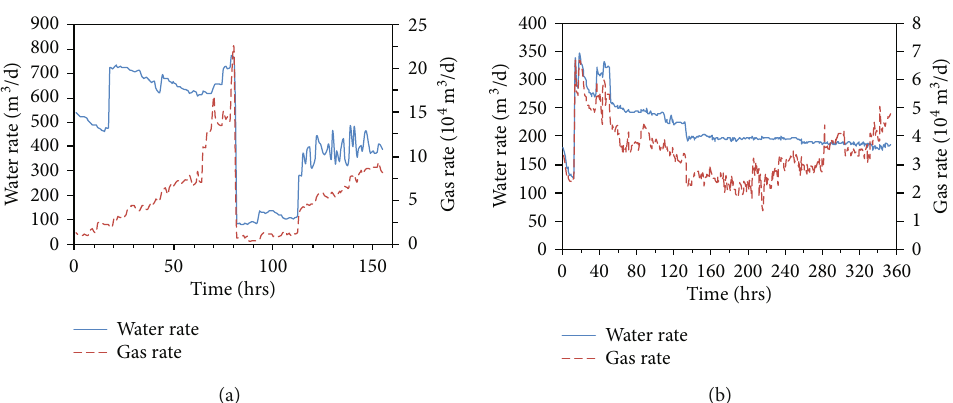
Figure 2: Diagnostic plots for two wells in shale gas formations belonging to southern Sichuan. (a) Production rate plot for Well 3. (b) Production rate plot for Well 4.